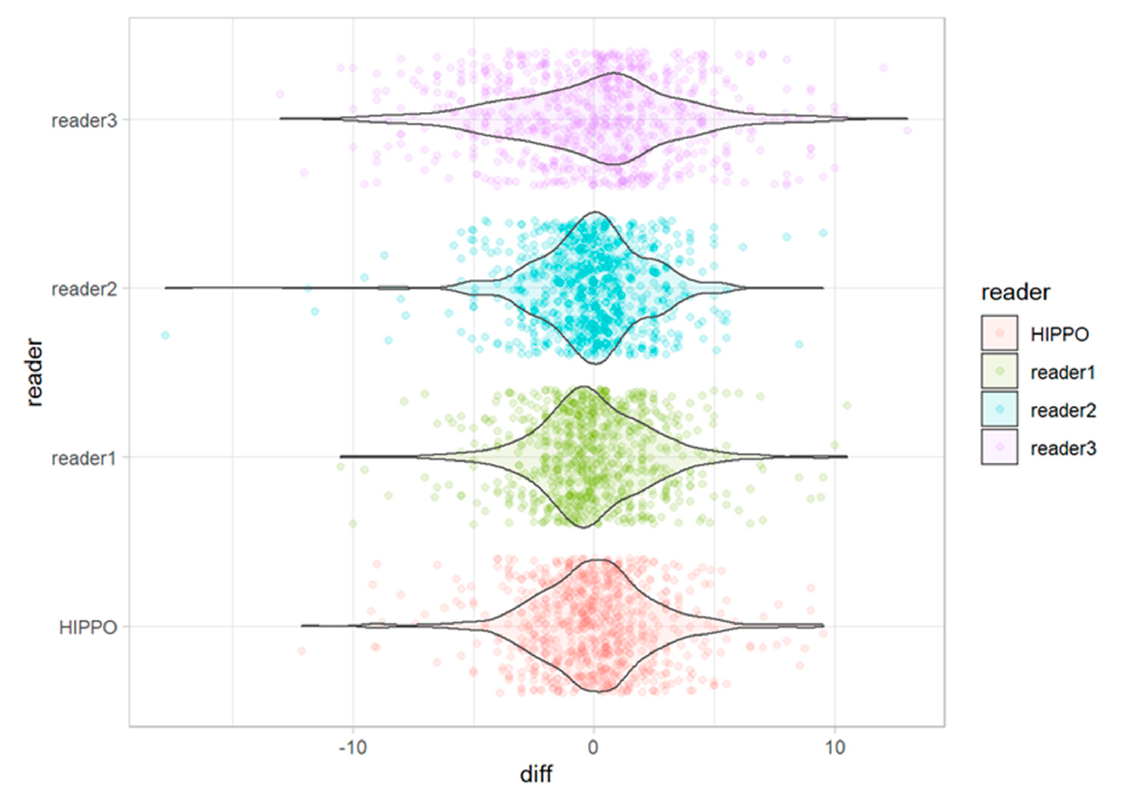
Figure 5. Deviation from the median for each individual observation for all readers and HIPPO™.